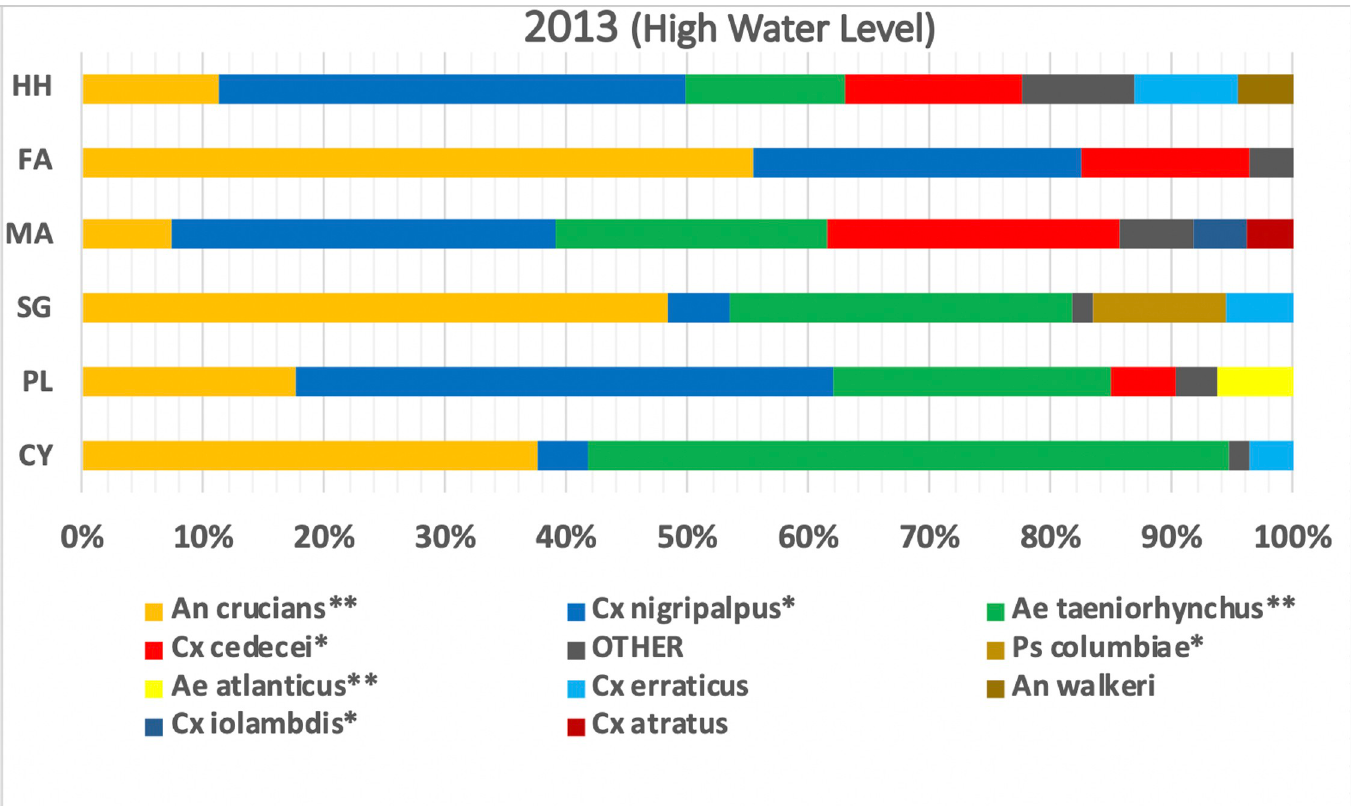
Fig 6. Distribution of mosquito species among landscapes during 2013. Hardwood hammock (HH), Fakahatchee (FA), mangrove (MA), sawgrass (SG), pinelands (PL), cypress (CY). One-way ANOVA levels of significant difference: � P < 0.05, �� P < 0.01.